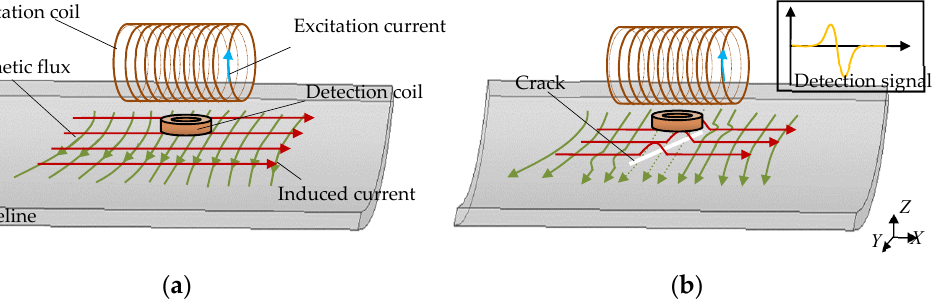
Figure 1. ( a ) Schematic diagram of electromagnetic distribution on the surface of the pipeline with- out defects; ( b ) schematic diagram of electromagnetic distribution on the surface of the pipeline with cracks.